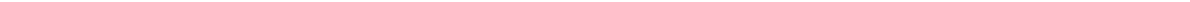
Fig. 6. SEM photos of chitinozoans from the Baldone drill core, central Latvia. The scale bar represents 100 μ m (A–H, r–ac), 200 μ